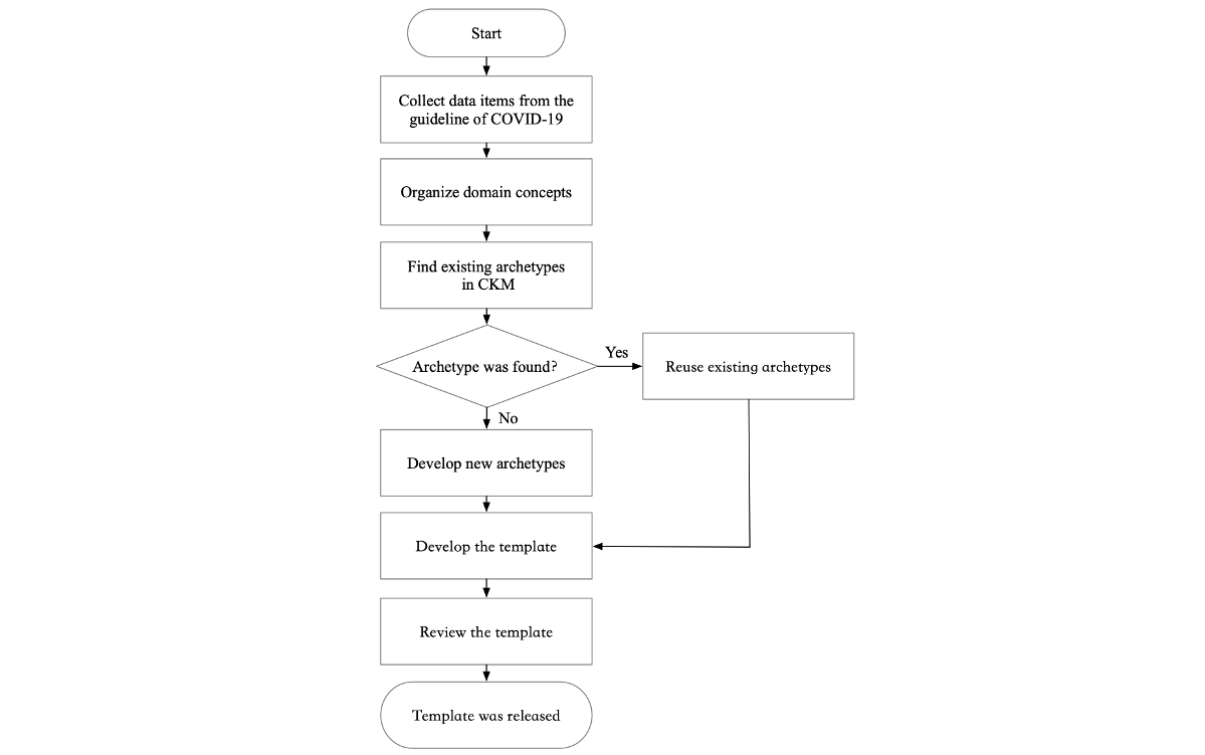
Figure 1. The method of developing an openEHR template about COVID-19. CKM: Clinical Knowledge Manager; COVID-19: coronavirus disease.